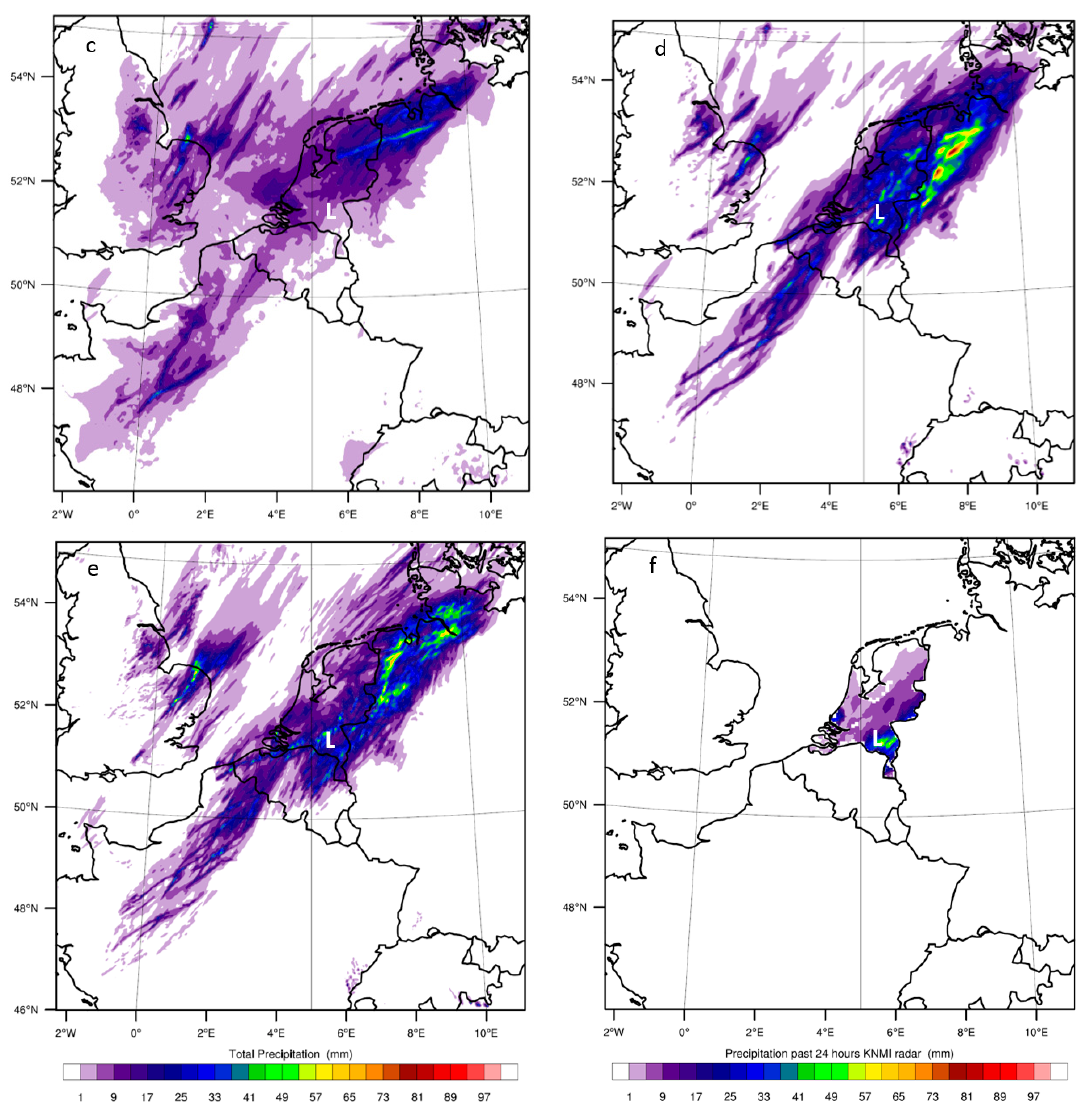
Figure 3. Modelled daily accumulated rainfall on 23 June 2016 ( a ) Kain–Fritsch; ( b ) Betts–Miller–Janjic, ( c ) Grell–Freitas ensemble; ( d ) explicit 4 km; ( e ) explicit 2 km; ( f ) observed daily accumulated rainfall between 23 June 2016 14:00 UTC and 24 June 2016 00:00 UTC. L indicates Luyksgestel.